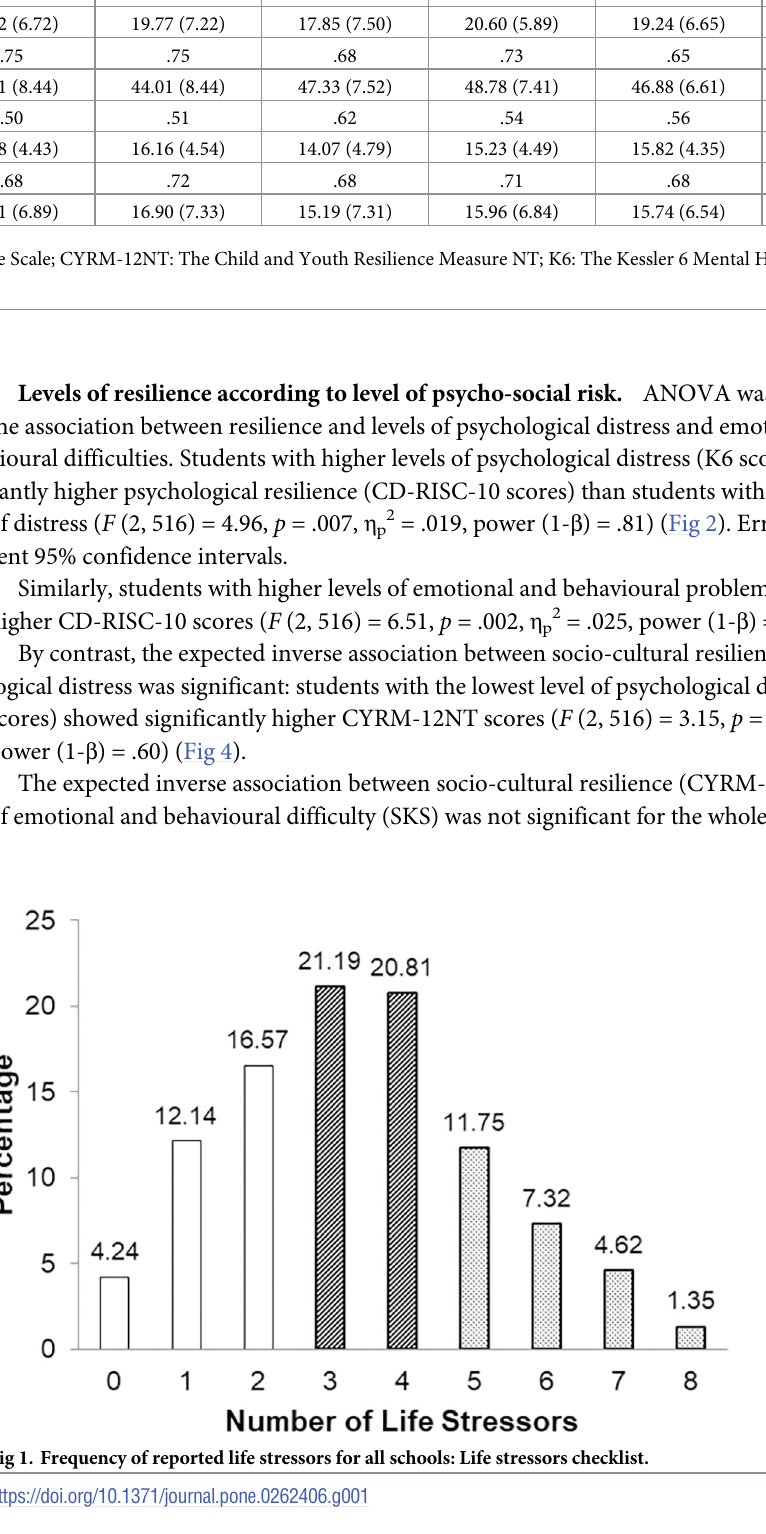
Table 4. Cronbach’s alpha, mean scores and standard deviations for all measures by school. Measures